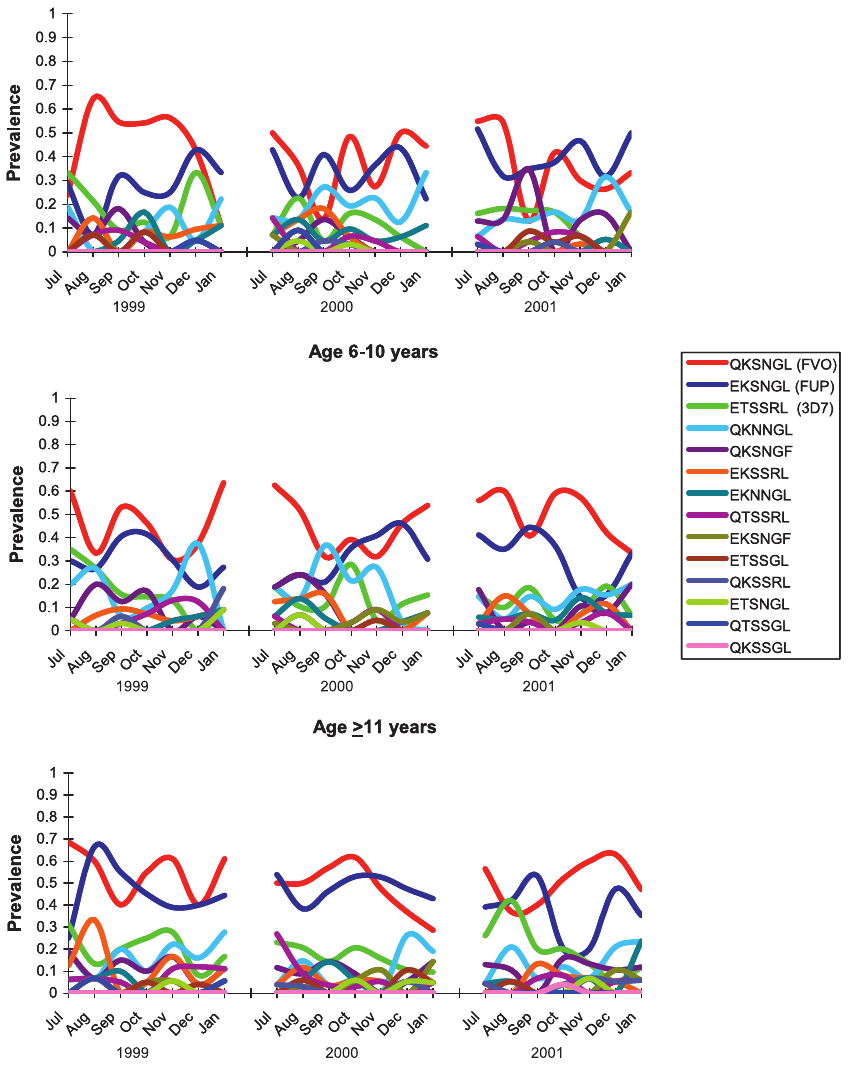
Figure 2. Prevalence of MSP-1 19 Haplotypes over Time in Three Age Groups Haplotype prevalences from July to January by age group during the three years of the malaria incidence study in Bandiagara, Mali.